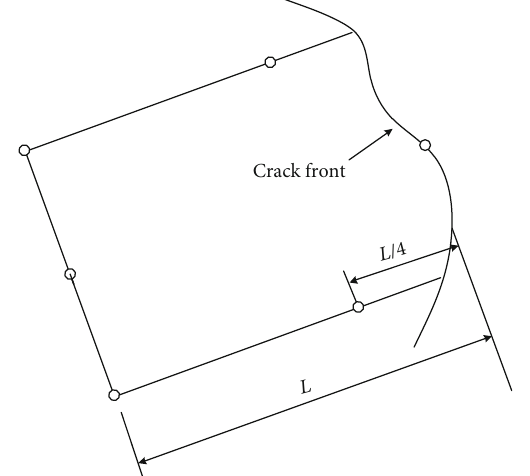
Figure 4: Quarter-point singular element to capture the singularity at the crack front.